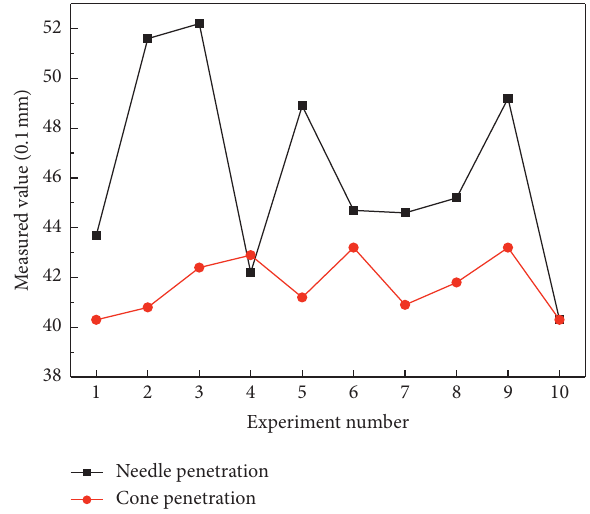
Needle penetration Cone Figure 3: The needle/cone penetration experimental results of AR binders with #20